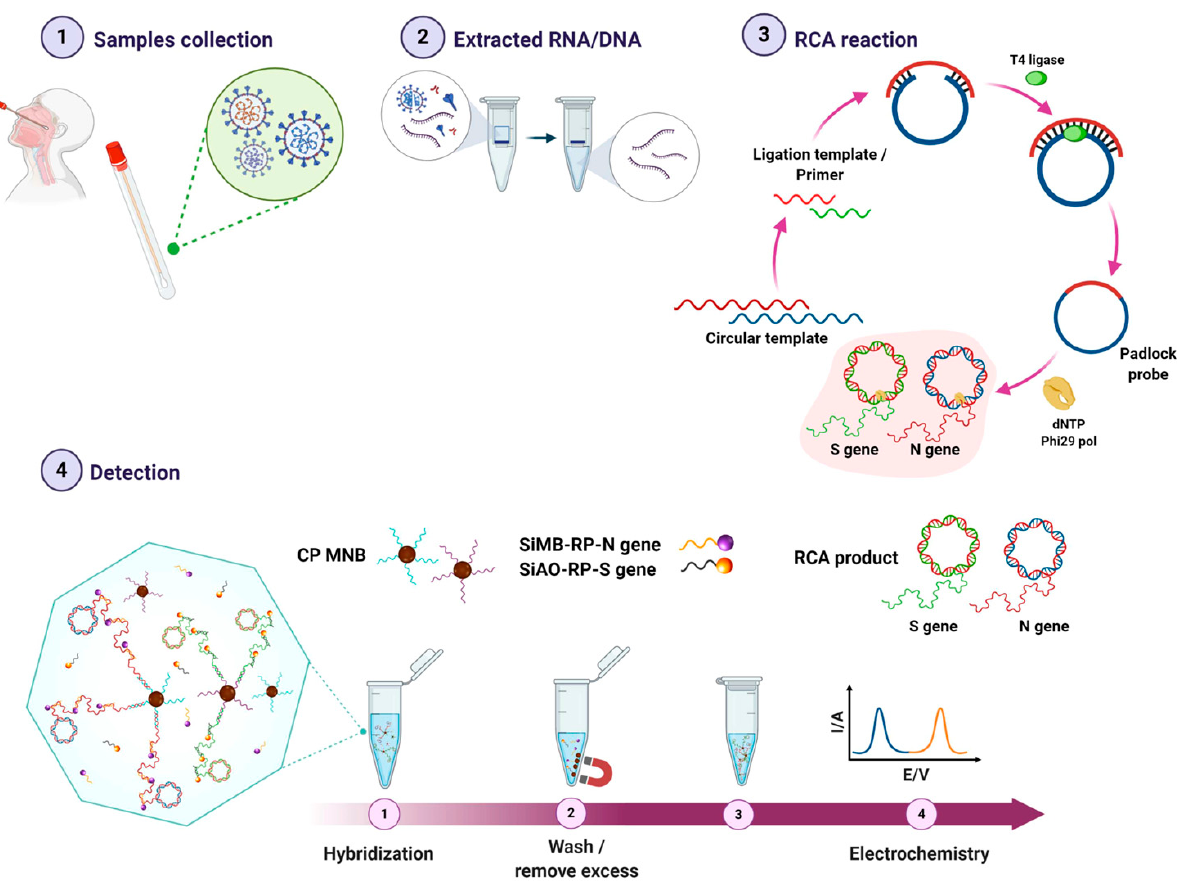
Figure 3. Workflow of the RCA-based electrochemical sensor for SARS-CoV-2 detection (Reprinted from Ref. [50]).